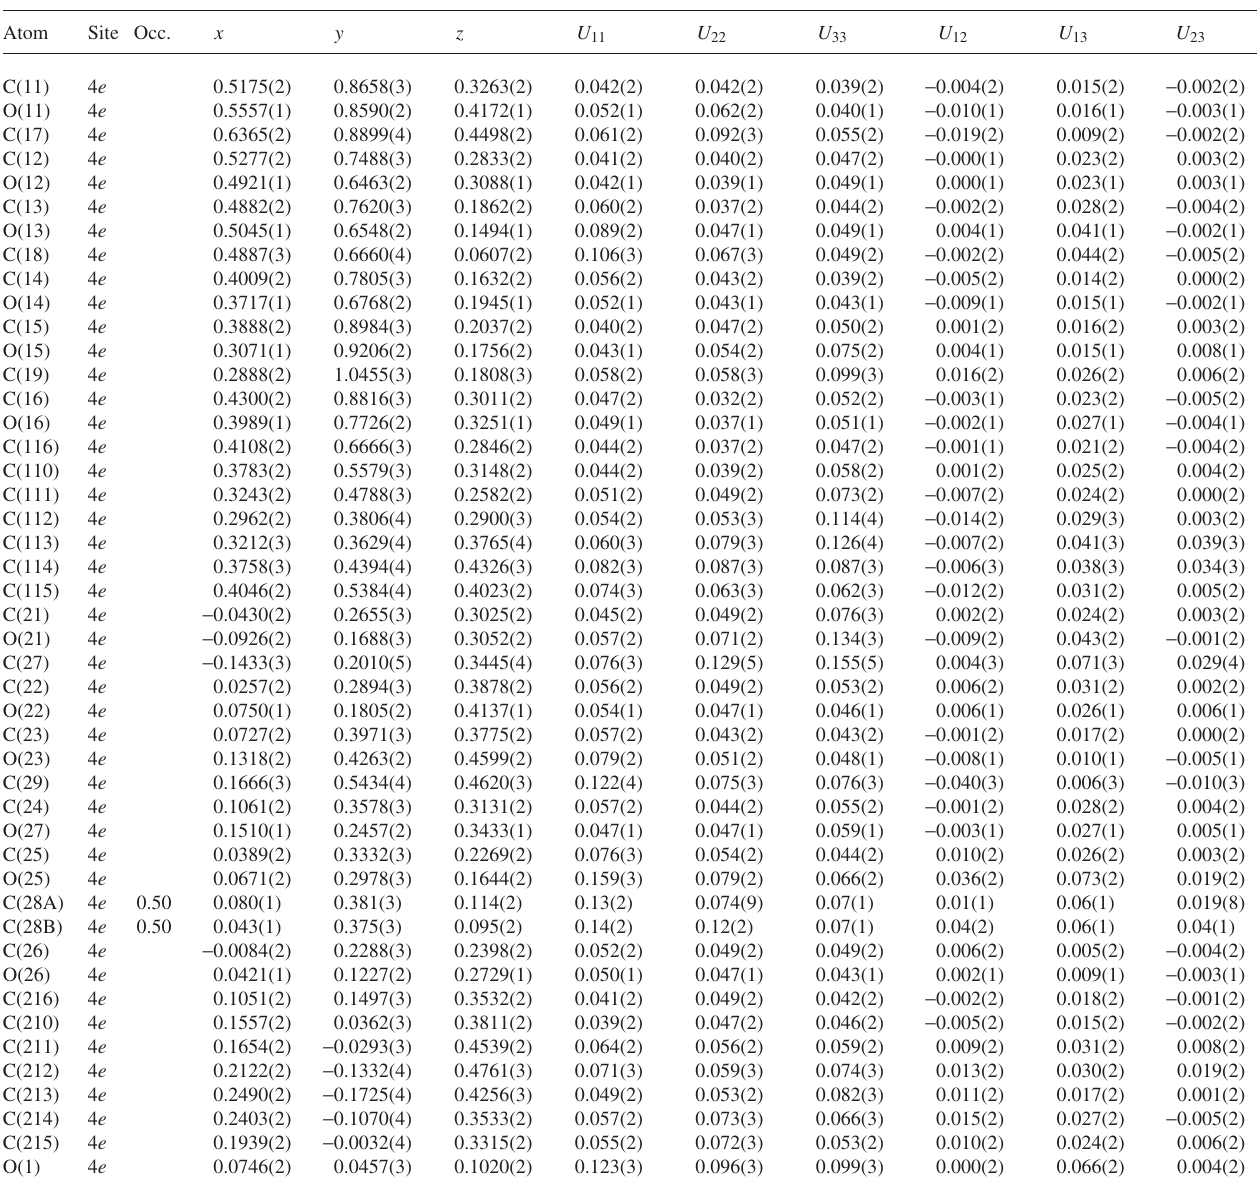
Table 3. Atomic coordinates and displacement parameters (in Å 2 )